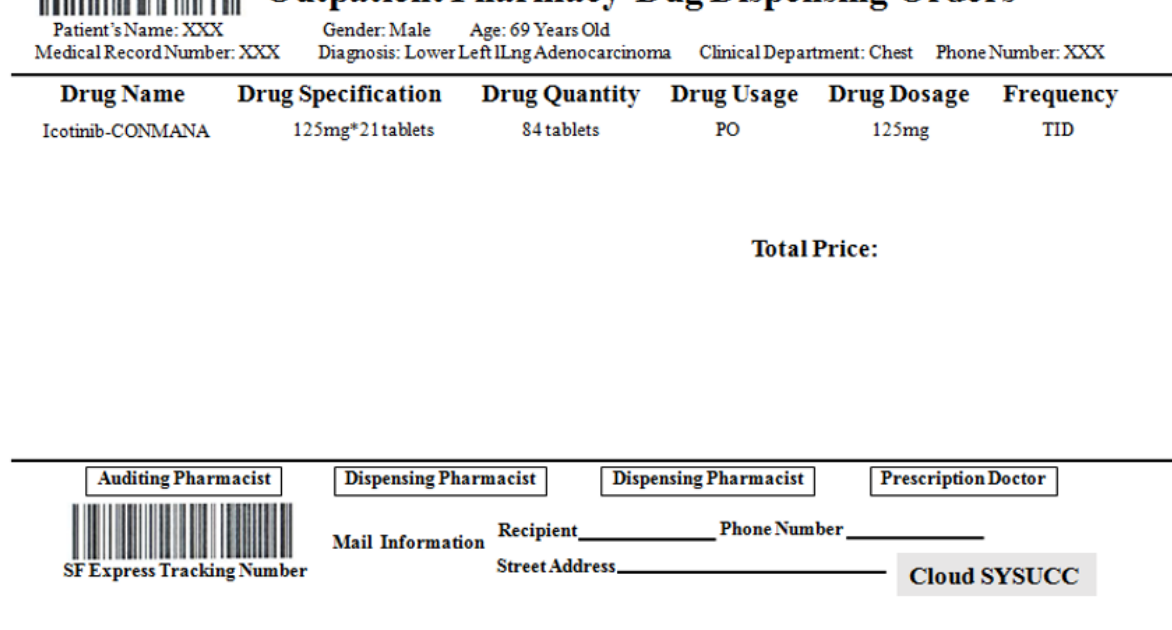
Figure 2. Example of a drug dispensing order generated using the Cloud SYSUCC app.